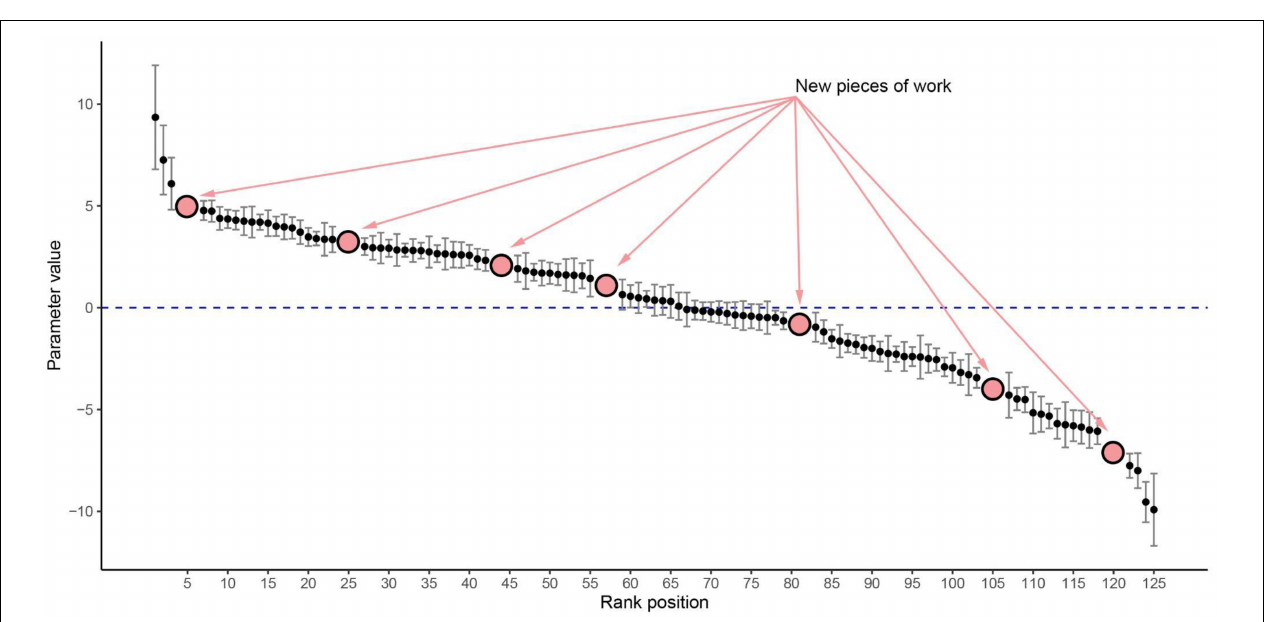
Vitello, 2019) should be